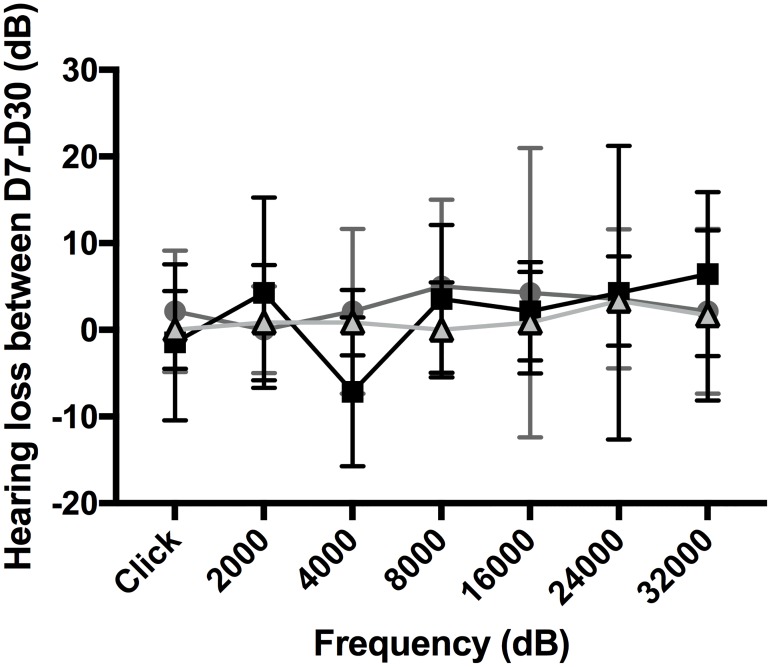
Influence of electrode array geometry on hearing loss.A: D7. B: D30. Hearing threshold shift measurement according to 0.4R (black squares) (n = 7), 0.4 (dark grey circles) (n = 7), and 0.3 (light grey triangles) (n = 6) electrode arrays, inserted at 0.25 mm/s. Values are means ± SEM. Statistical analysis was with two-way Anova (p<0.001 at D7, and p<0.05 at D30), comparison between 0.3 and 0.4R (*p<0.05, **p<0.01, ***p<0.001), comparison between 0.4 and 0.4R ($p<0.05).